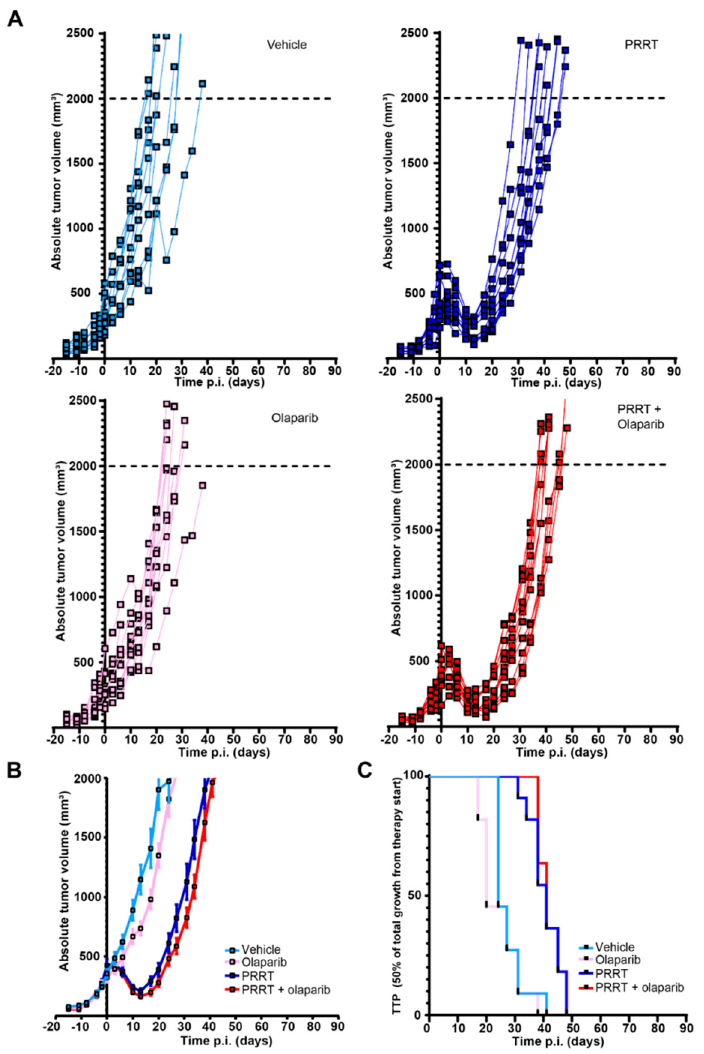
Figure 3. Combining PRRT and olaparib does not increase therapeutic efficacy compared to PRRT monotherapy in mice bearing NCI-H69 tumors. ( A ) NCI-H69 tumor growth curves showing absolute tumor volumes of mice that were treated with vehicle, olaparib, PRRT or the combination of PRRT and olaparib. ( B ) Combination of all absolute tumor volumes per treatment group. Error bars indicate the Standard error of the mean. ( C ) TTP shown by Kaplan-Meijer curves of NCI-H69 tumor bearing mice that were treated with vehicle, olaparib, PRRT or the combination of PRRT and